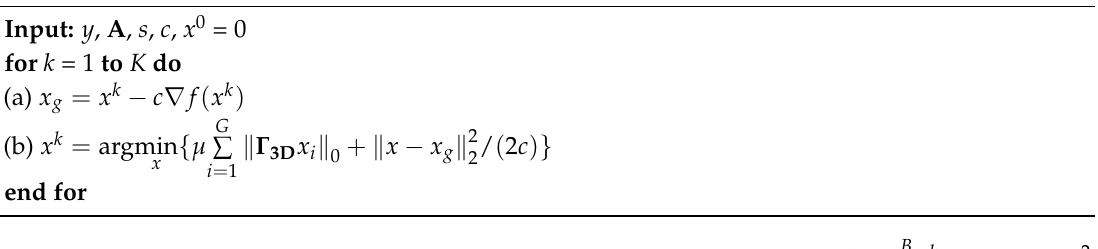
Algorithm 2 IST with Adaptive Nonlocal Regularization